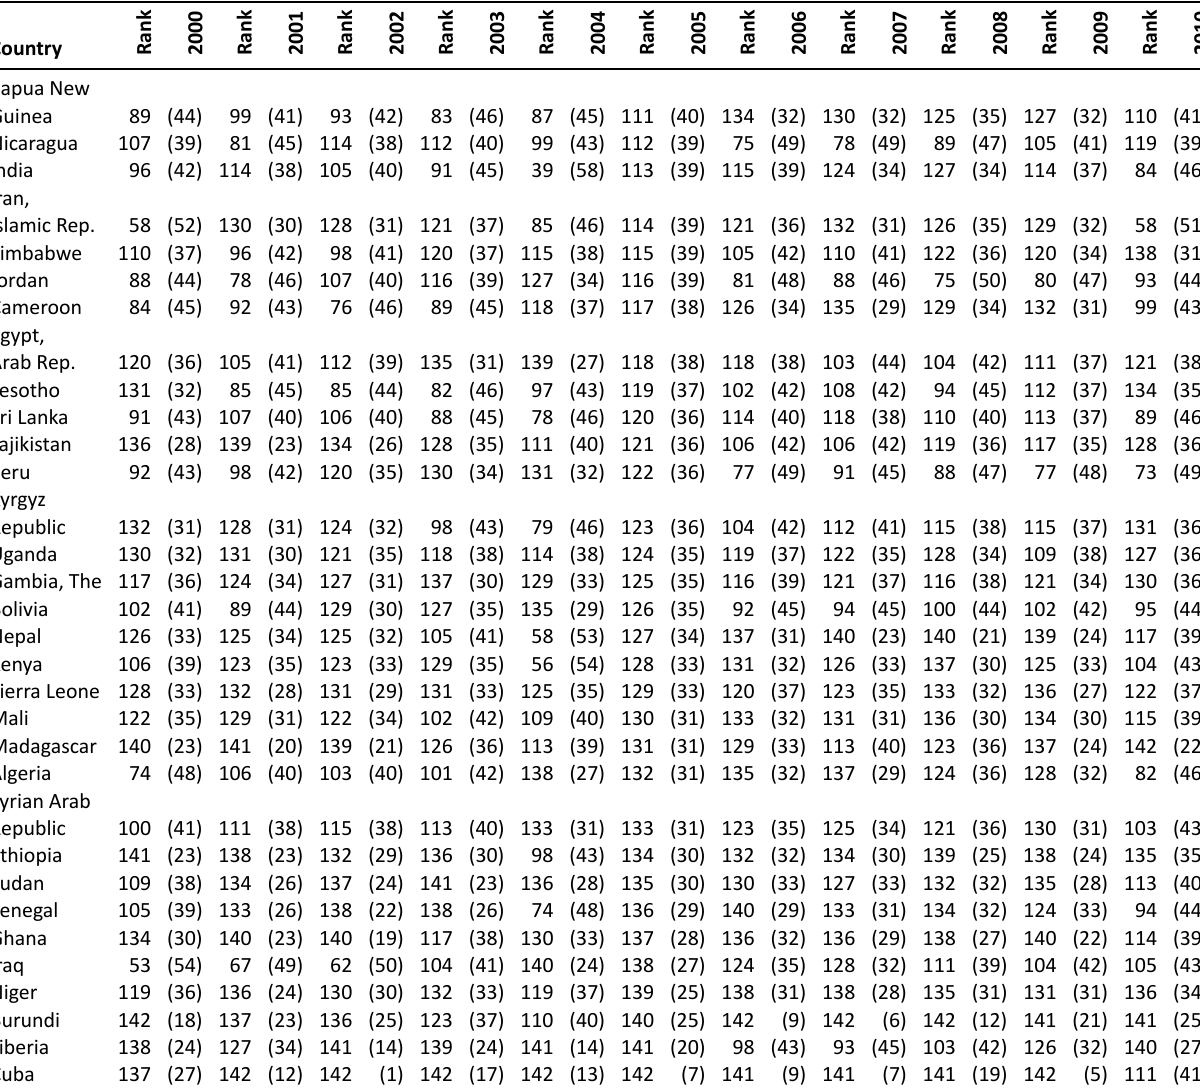
Note: The rank details the country rank of each country in that year according to the index value in parentheses. Countries are ranked according to their score in